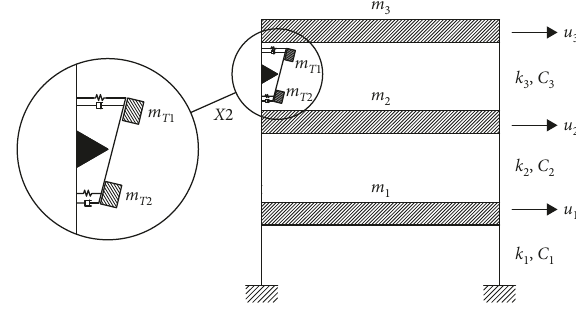
Figure 4: A three-story building structure.